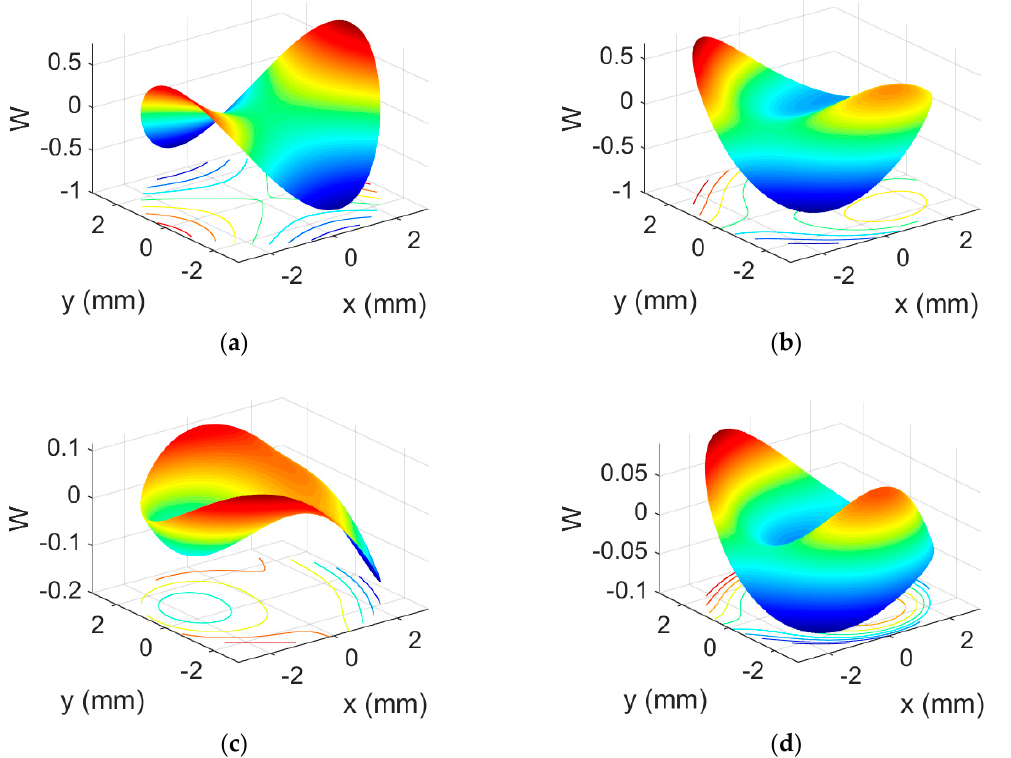
Figure 5. Wavefront aberration ( 𝑊 ) of positive symmetrical ( a ) and ( b ), and negative asymmetrical ( c ) and ( d ); HLs reconstructed at 633 nm ( a ) and ( c ), and at 473 nm ( b ) and ( d ).